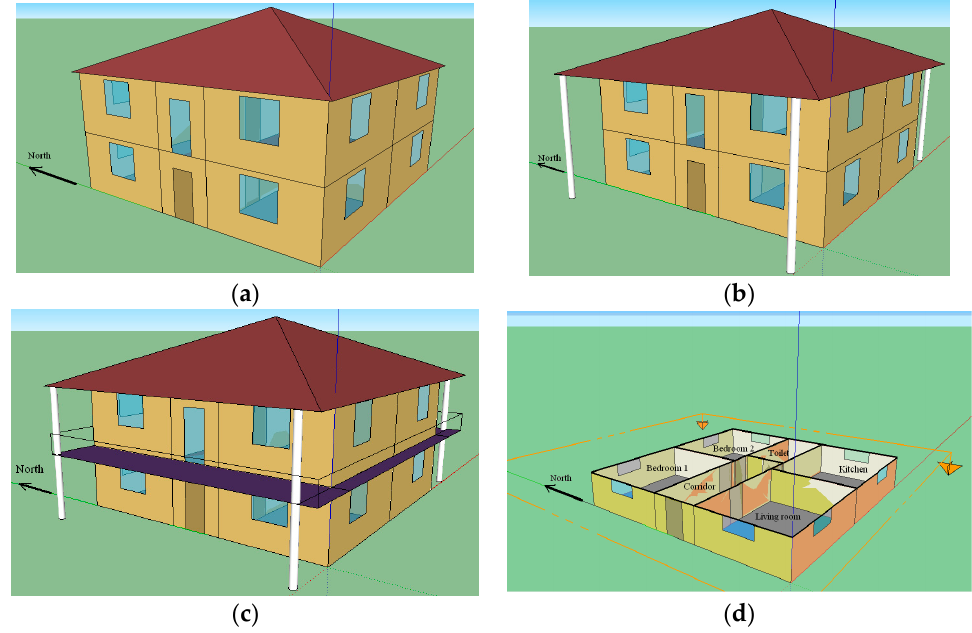
Figure 1. The house geometry: ( a ) basic building, ( b ) ORO building, ( c ) OBO building, and ( d ) the cross section of the first story of these buildings.